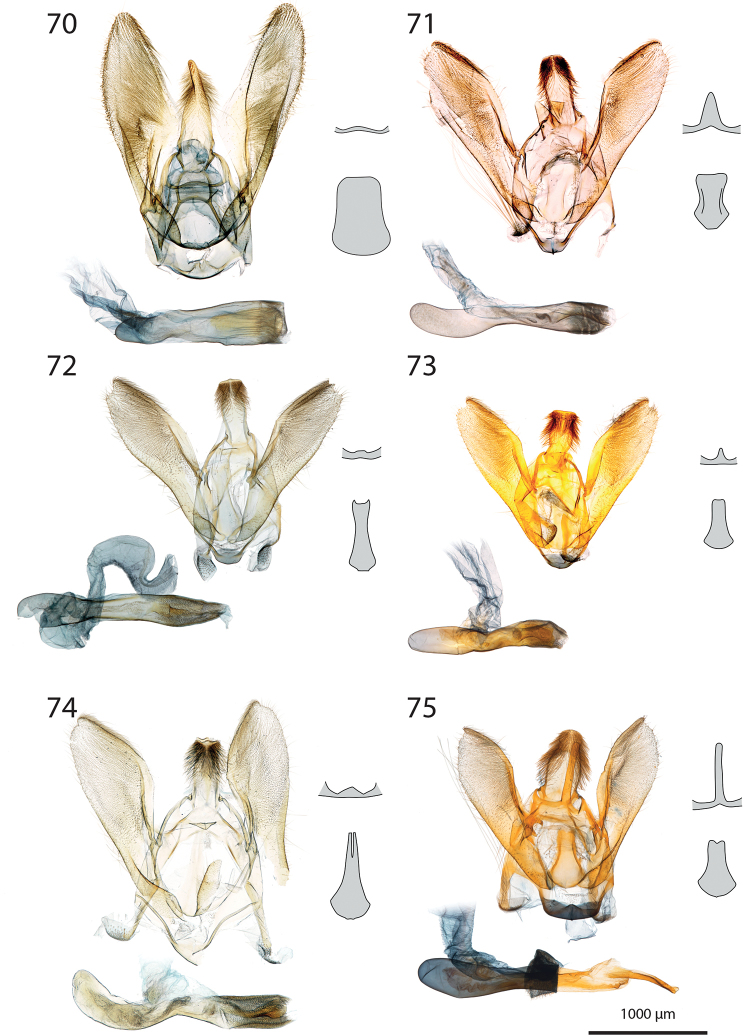
Male genitalia features of Hoploscopa. 70Hoploscopa
nauticorum, TL725 ♂ 71Hoploscopa
anacantha sp. nov., holotype, TL759 ♂ 72Hoploscopa
kelama sp. nov., paratype, TL511 ♂ 73Hoploscopa
ignitamaculae sp. nov., paratype, TL545 ♂ 74Hoploscopa
albomaculata sp. nov., paratype, TL363 ♂ 75Hoploscopa
sumatrensis sp. nov., paratype, TL538 ♂.